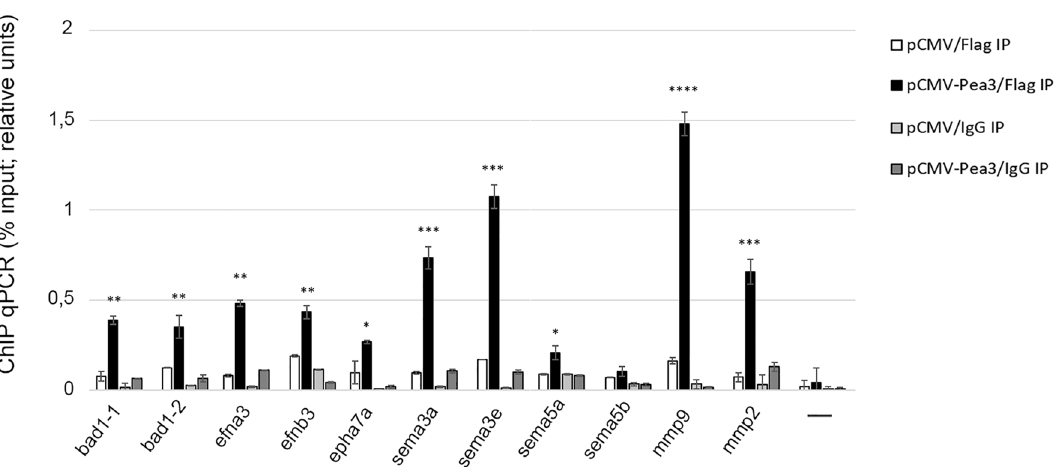
Figure 6. Chromatin IP (ChIP) analysis of selected promoters for Pea3 binding. SH-SY5Y cells were transfected either with pCMV or pCMV-Pea3 and cell lysates were immunoprecipitated with either Flag antibody (Flag IP) or IgG (IgG IP), followed by ChIP-qPCR for the indicated promoter motifs. The error bars show the SEM for 2 independent experiments. p values: * < 0.05; ** < 0.01; *** < 0.001; **** < 0.0001; ANOVA (one